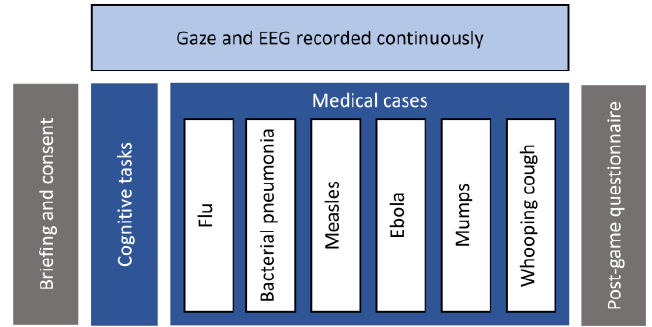
Figure 1. Experimental procedure.